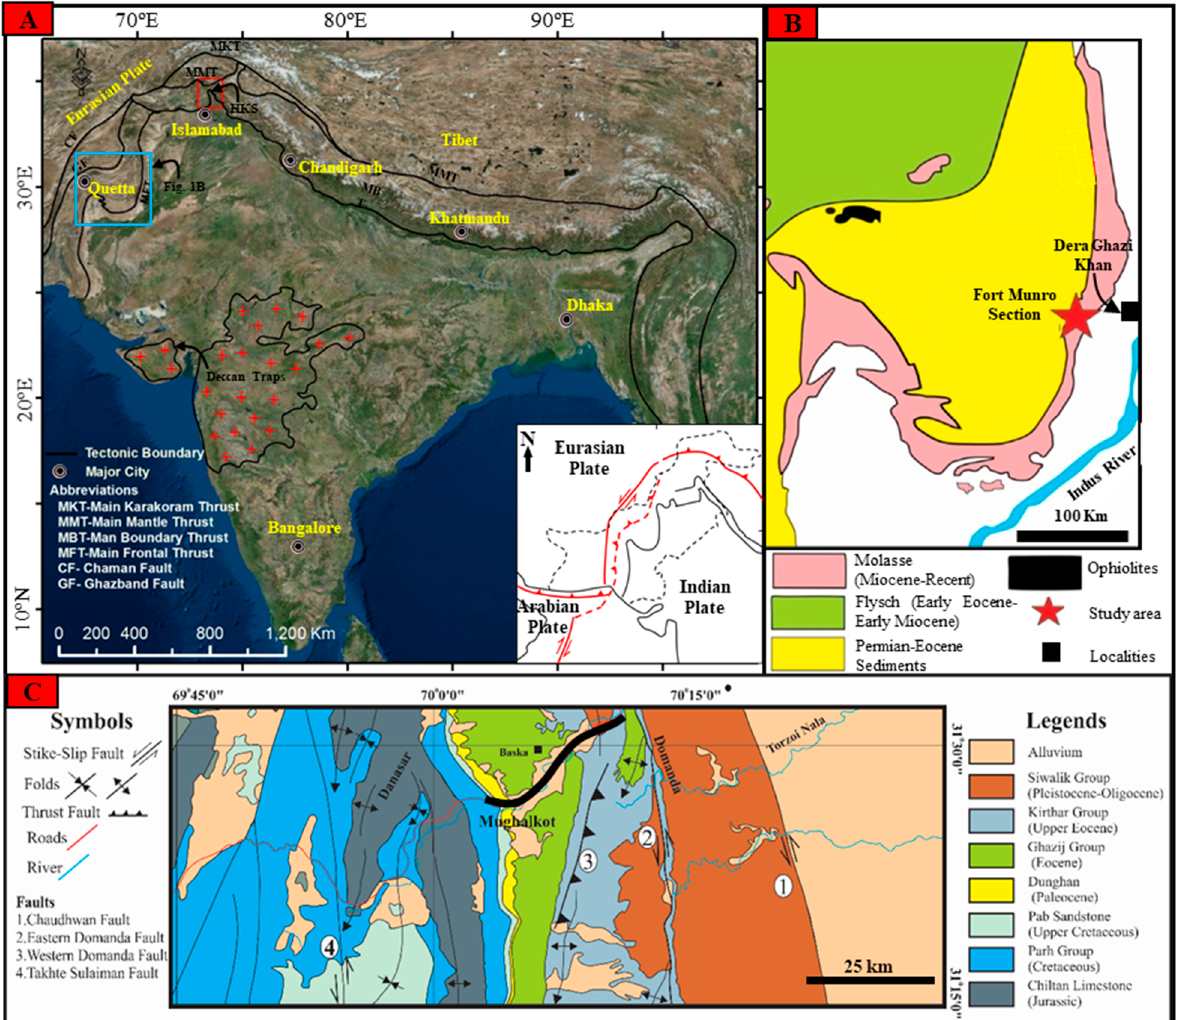
Figure 1. ( A ) Simplified map showing regional tectonic features. The blue rectangle shows the location of the Sulaiman fold–thrust belt (SFB), and the red rectangle shows the Hazara–Kashmir syntaxial bend (after [11]). ( B ) The simplified geological map of SFB, showing the location of the studied section (after [21]). ( C ) Geological map of the study area, showing major geological units [22]. The solid black line represents the location of the Mughalkot